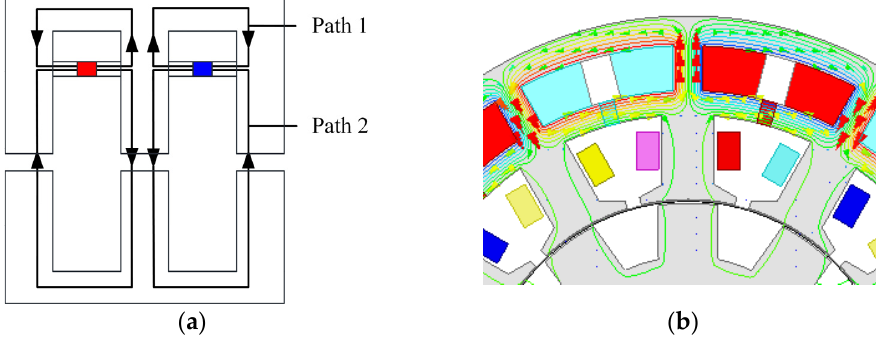
Figure 2. Magnetic flux paths of PM excitation: ( a ) theoretical paths; ( b ) FEA paths.